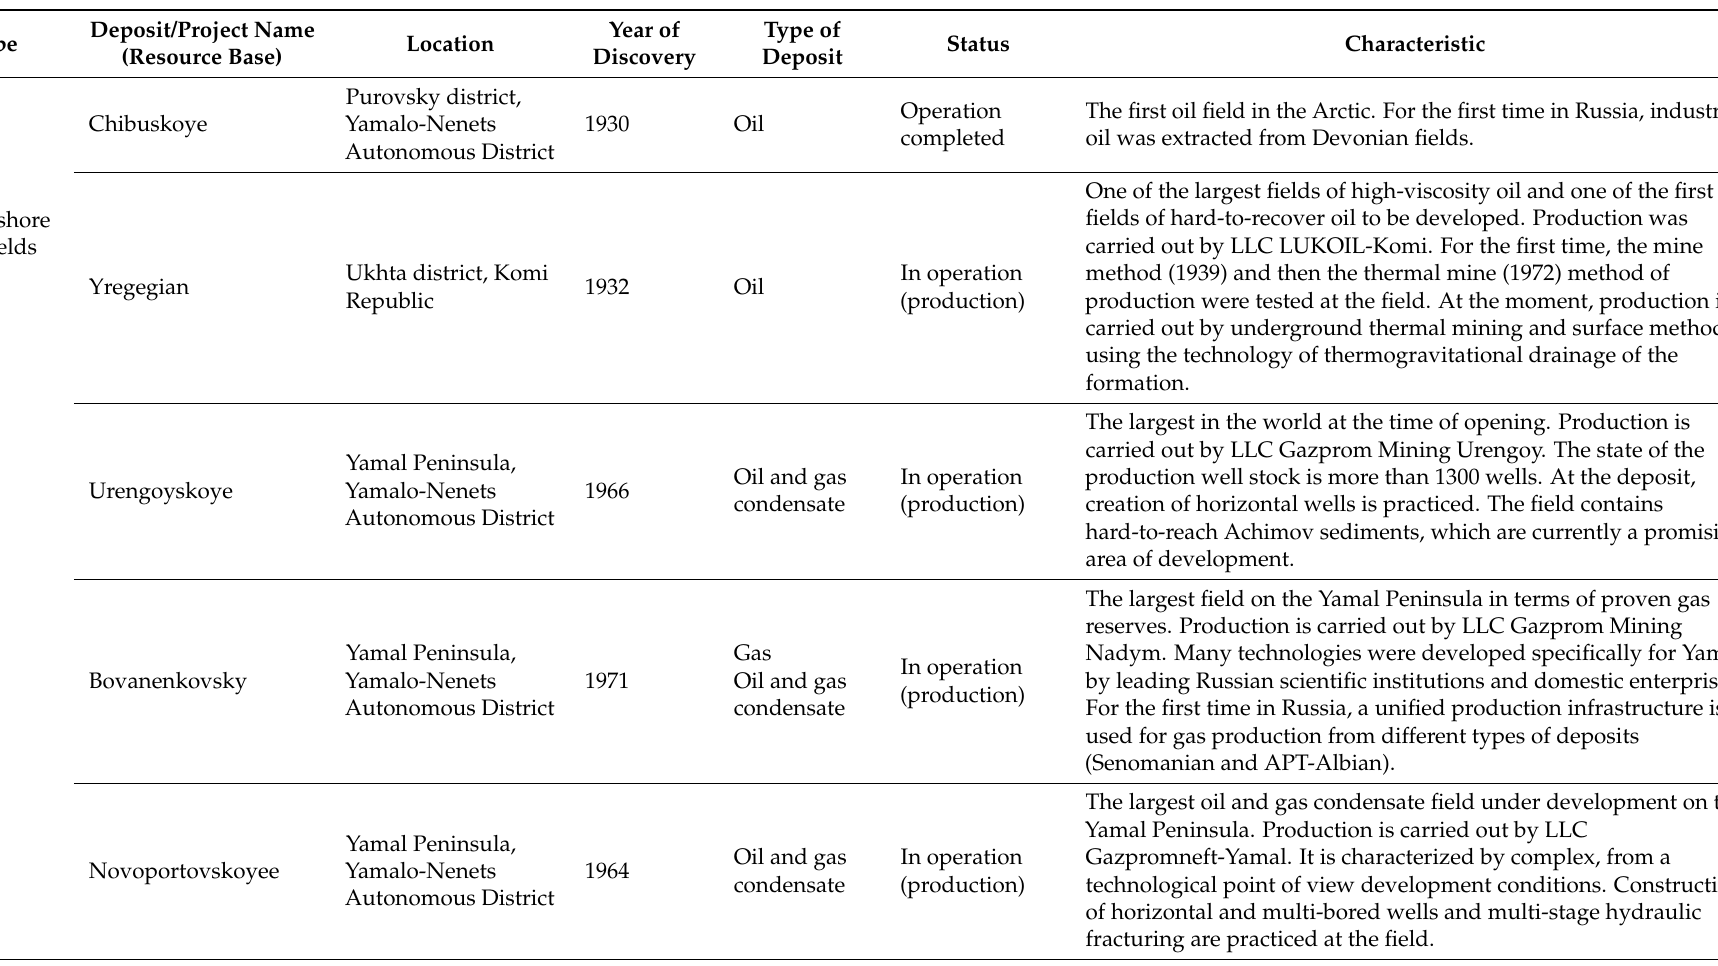
Table A1. Significant oil and gas projects implemented in the Russian Arctic (created by the authors, based on